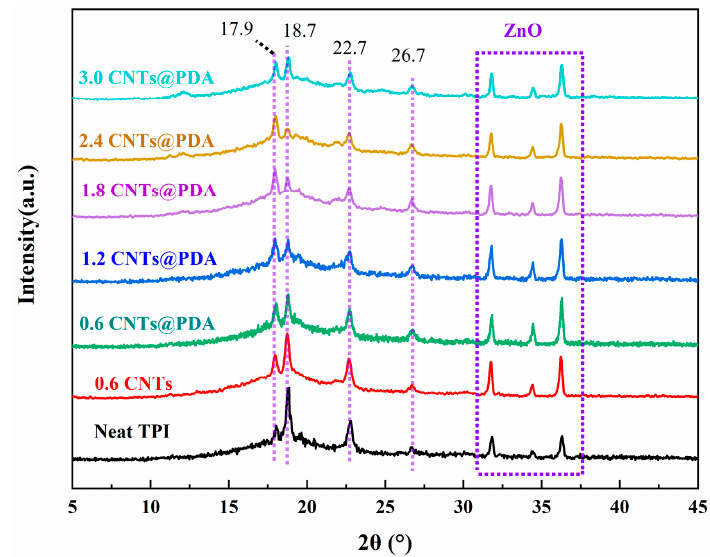
Figure 8. XRD profiles of TPI Composites.